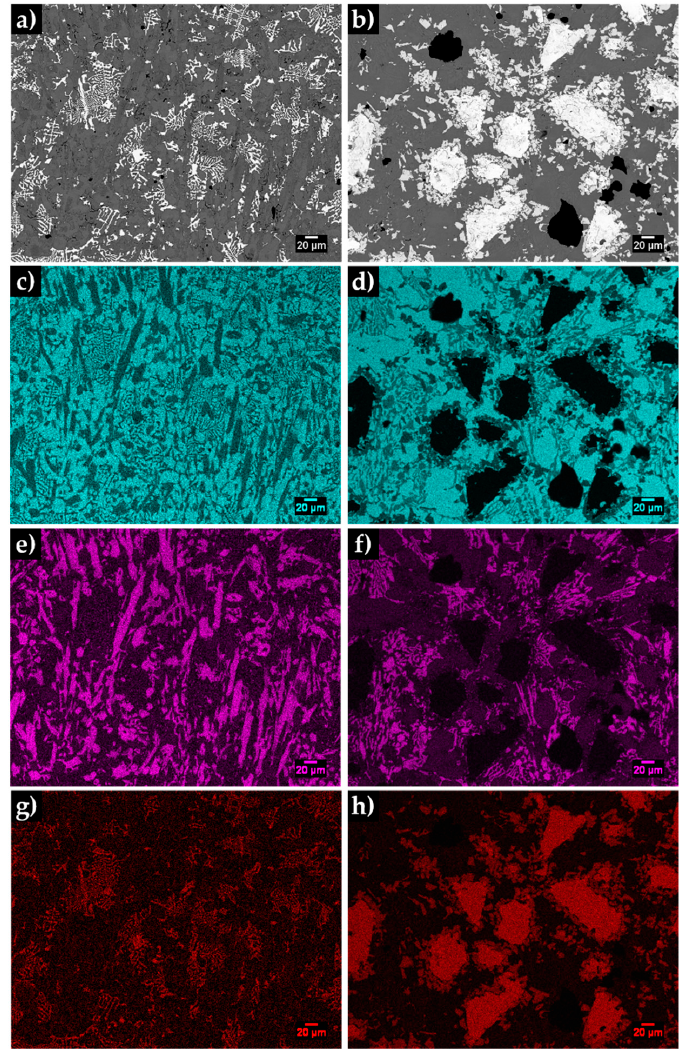
Figure 15. SEM-BSE images of the microstructure of the reaction layer ( a ) and composite zone ( b ). EDS elemental mapping ( c-h ) of Fe (blue), Cr (pink) and W (red).